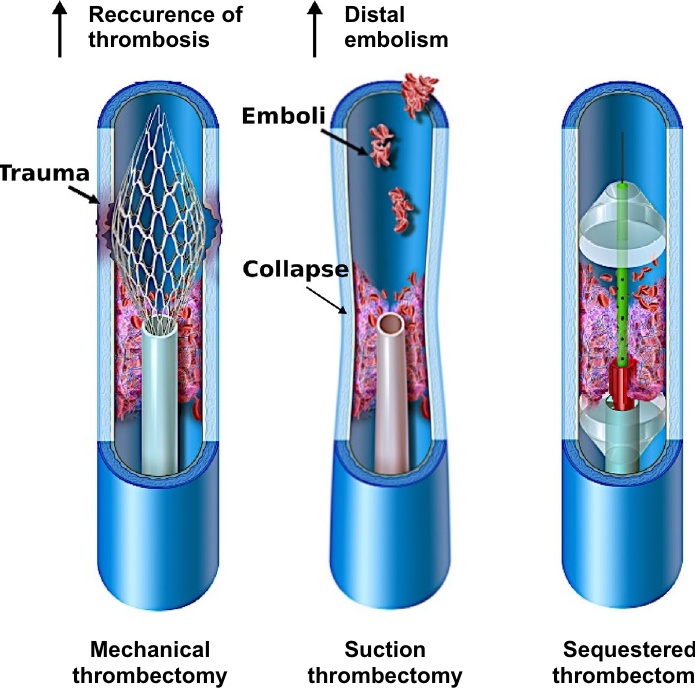
Figure 1. Comparison of traditional thrombectomy treatment options and a novel multi-modal sequestering thrombectomy catheter. The graphics in this figure were drawn by Matt Holt (medical-illustrator@bodyrender.